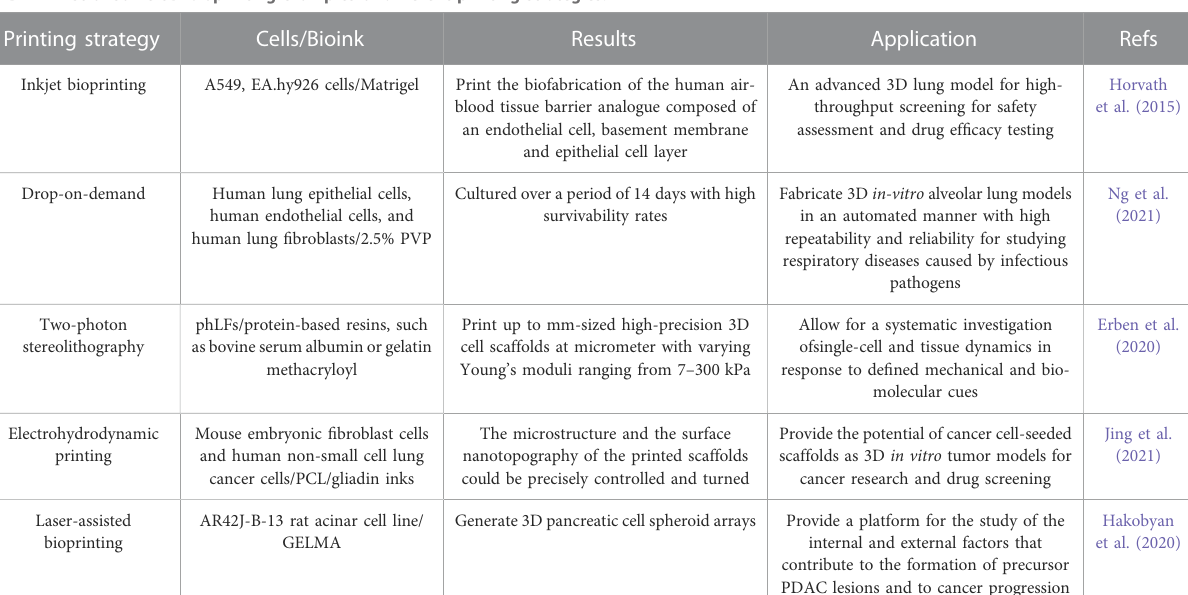
TABLE 4 List of some 3D bioprinting examples of different printing